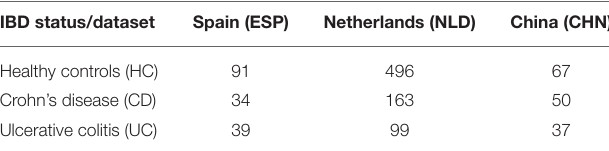
TABLE 1 | Number of samples per dataset and per clinical status analyzed in this